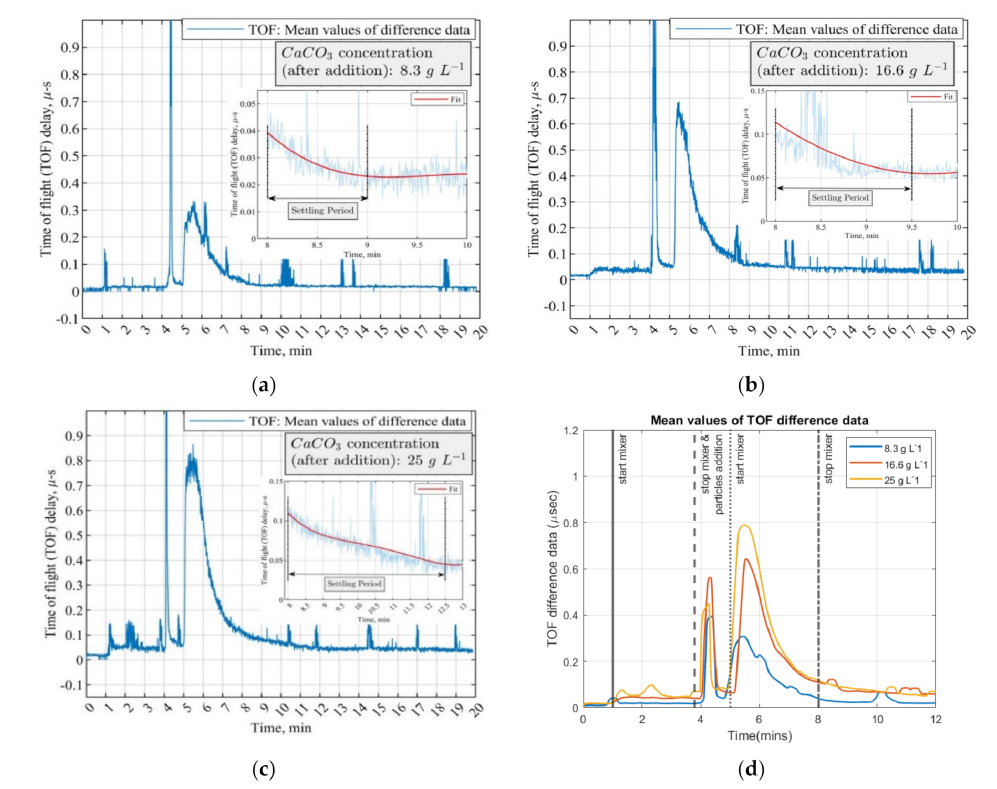
Figure 9. Mean values of the time-of-flight difference data in four concentrations of CaCO 3 suspen- sions. Experimental procedures are the same for all the concentrations. The initial volume of water is 3 L. Settling period is defined to calculate the settling velocity of particles. ( a – c ) Plot for 8.3 g, 16.6 g, and 25 g; ( d ) all the mean values from ( a – c ) in one